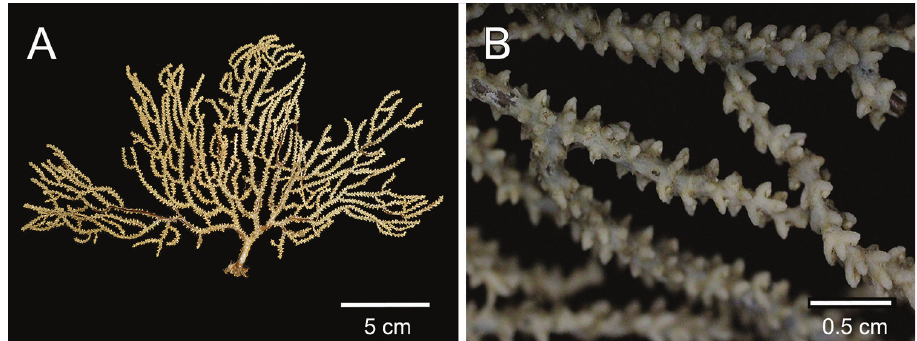
Figure 1. Muricea subtilis sp. n., UCR 2322 (holotype). A Colony B Detail of branches.